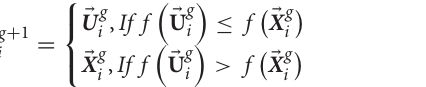
H D (cid:12) (cid:12)